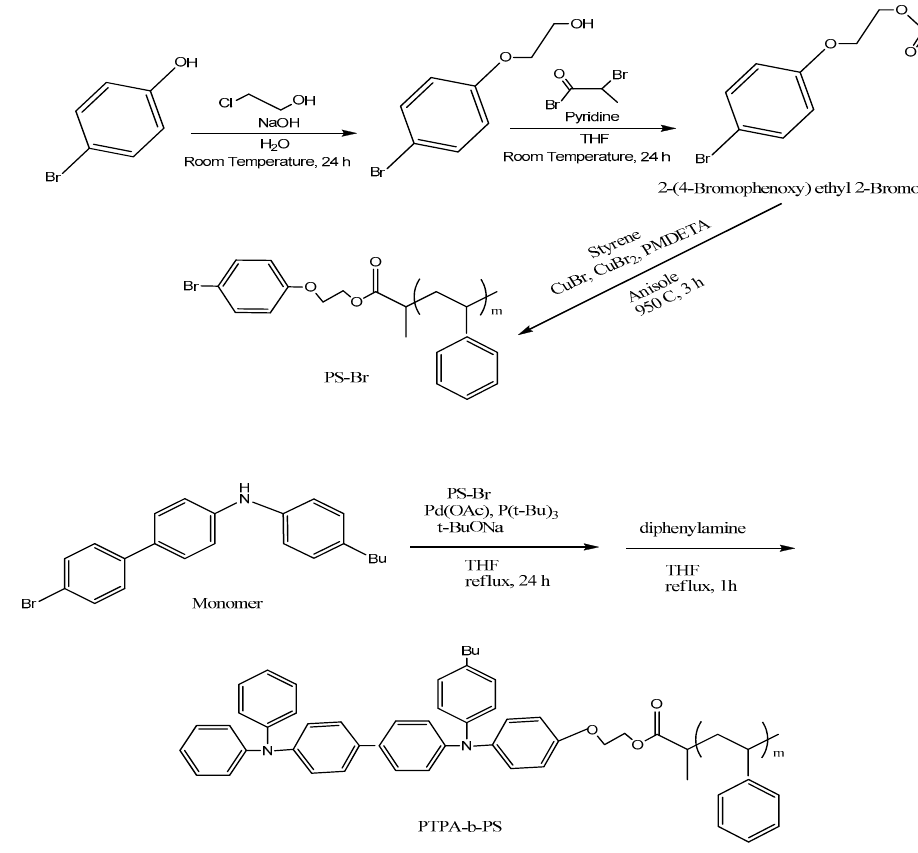
Figure 6. Synthesis of PTPA- b -PS using PS-Br as a terminal modifier via C–N coupling polymerization.